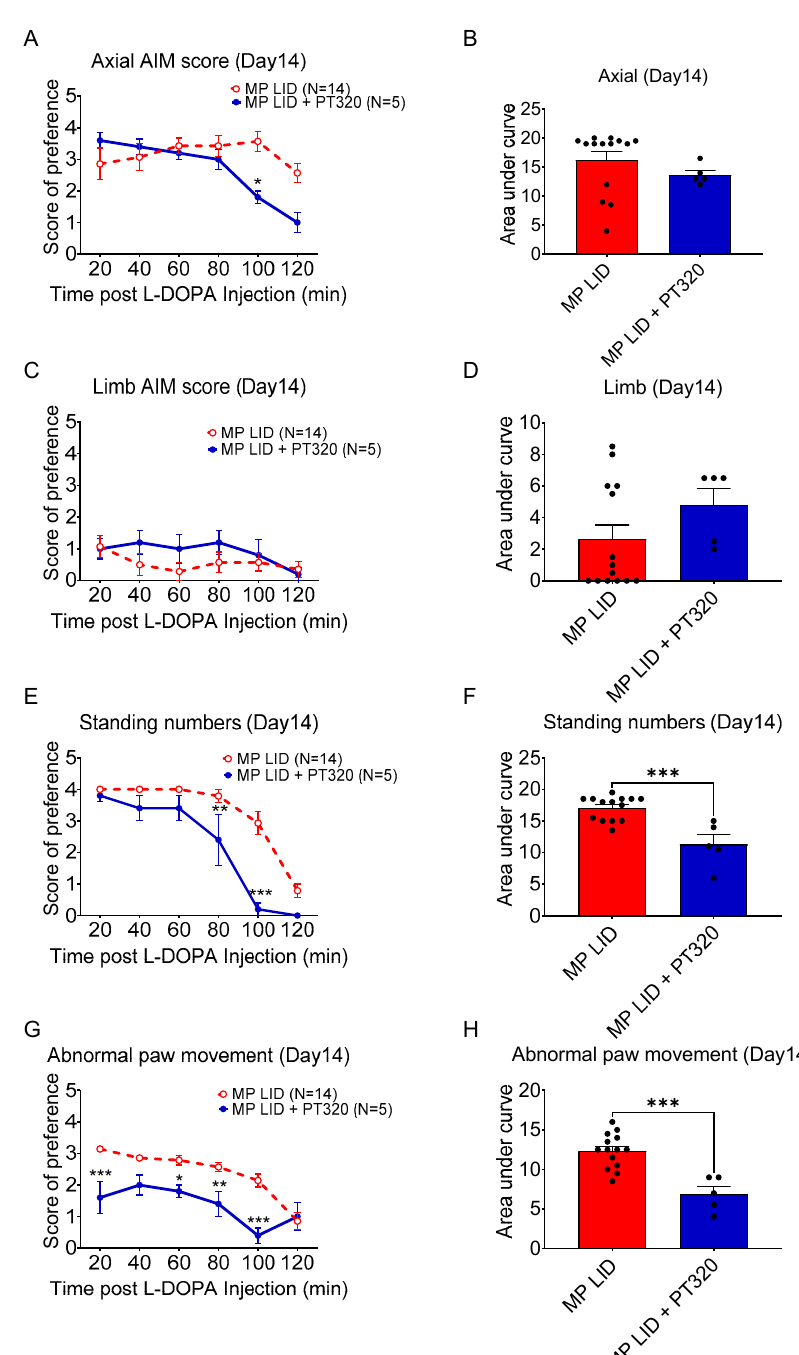
Figure 3. The detailed AIM score components were analyzed between the early 5W PT320 treatment and non-treatment groups at Day 14 of LID induction. ( A ) The axial scores revealed that abnormal axial deviation decreased to normal at the last recording time ( B ) The area under the curve of the scores revealed less severe dyskinesia in the PT320 treatment group compared with the non-treatment group (MP LID group). ( C , D ) There were no significant differences in limb AIM scores between groups. ( E ) Abnormal standing time decreased significantly in the PT320 treatment group with less area under the curve in the PT320 treatment group ( F ). ( G ) The score for abnormal paw movement was less in the PT320 treatment group with a significantly lower area under the curve in the PT320 treatment group ( H ). Two-way analysis of variance (ANOVA) followed by Bonferroni post hoc test for multiple comparisons. * p < 0.05, ** p < 0.01, *** p < 0.001 compared with MP